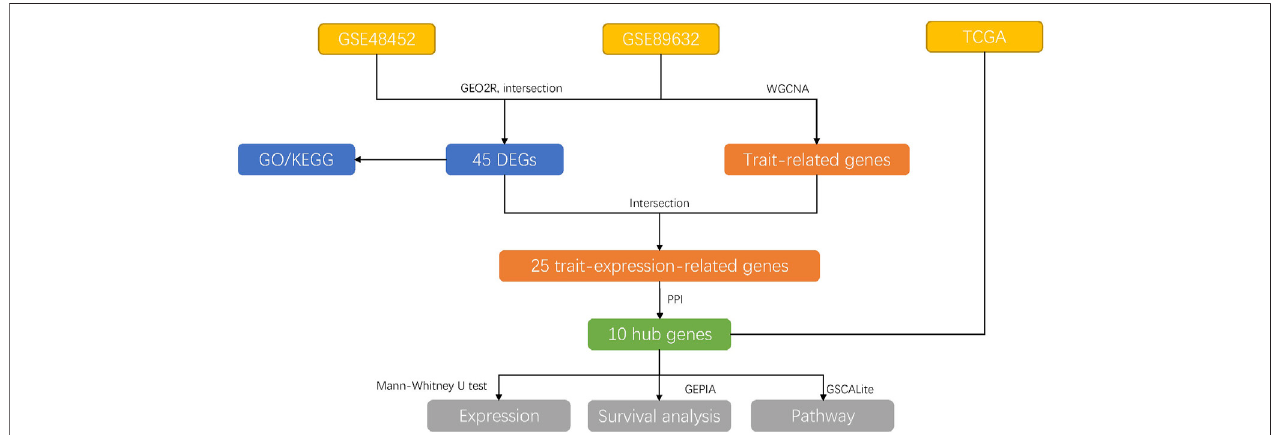
FIGURE 1 | The overall research designs. The data were downloaded from GEO and TCGA databases. Then, the DEGs were explored among the groups using GEO2RandwereperformedGOandKEGGanalysislater,respectively.Subsequently, theGSE89632dataset wasusedforWGCNAanalysistoexplorethetrait-related genes, which were intersected with the DEGs to fi nd trait-expression-related genes. PPI network analysis was performed to detect hub genes. Then, the expression, survival rate, and pathway of 10 hub genes were explored in the TCGA